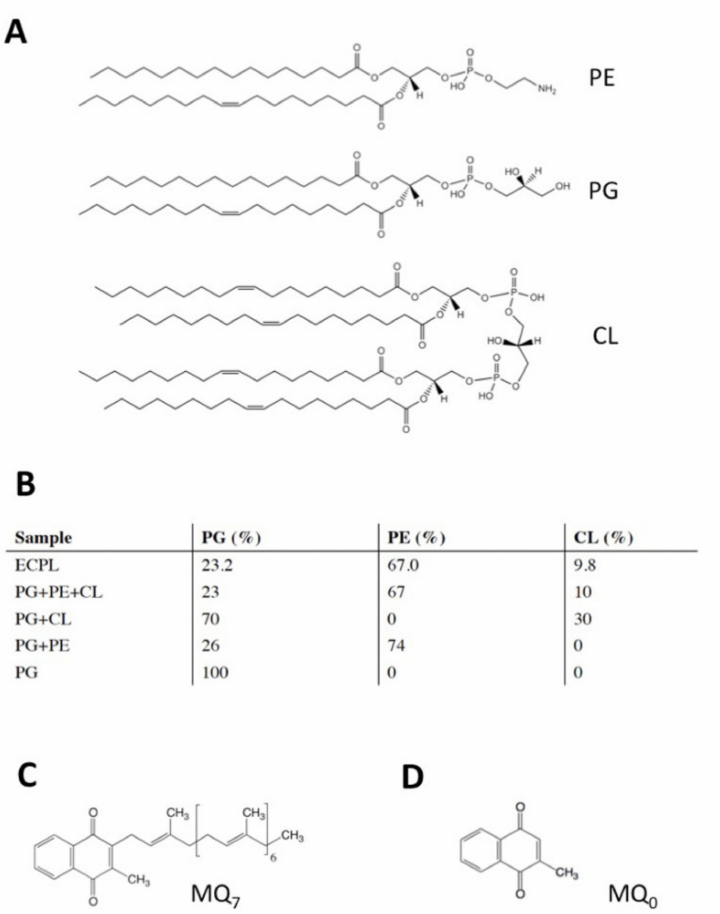
Figure 1. Vesicle compositions used in this study. ( A ), Structures of E. coli polar lipids: phos- phatidylethanolamine (PE), phosphatidylglycerol (PG), cardiolipin (CL). ( B ), Lipid compositions used in this study; values indicate % ( w / w ) of total lipid mixture. ( C ) Structure of menaquinone-7 (MQ 7 ) and ( D ) structure of menadione (MQ 0